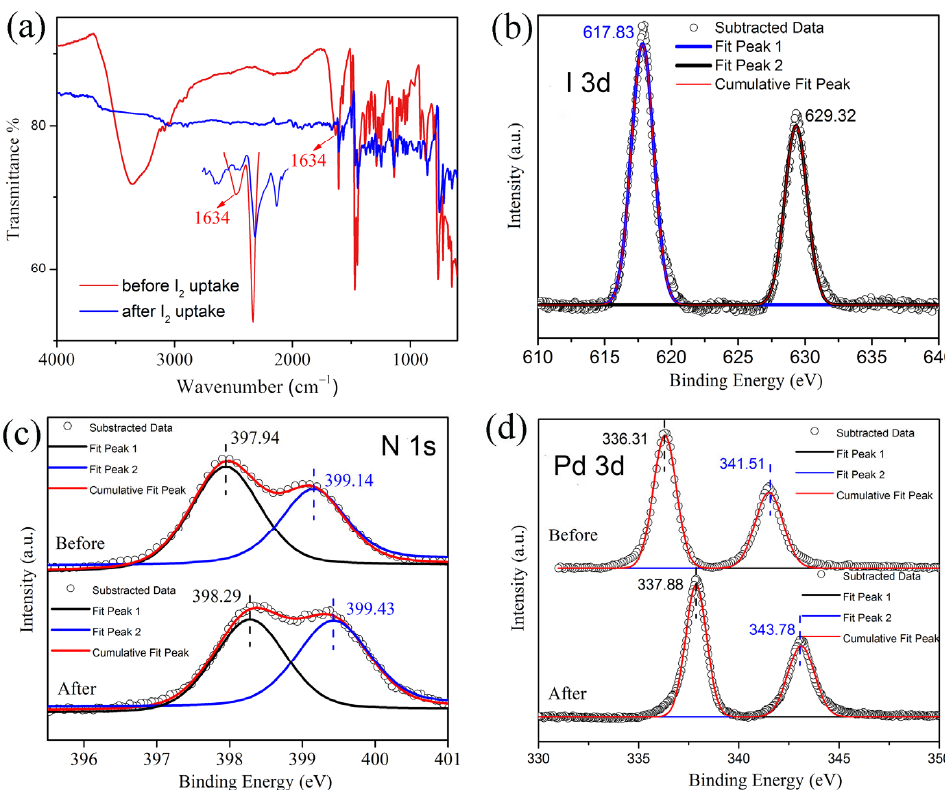
Figure 4 . ( a ) IR spectra of compound 1 before and after I 2 uptake (inset: enlarged spectra showing the significant decrease of band at ∼ 1640 cm − 1 ). ( b ) XPS of I 3d for I 2 @ 1 . ( c ) XPS of N 1s for compound 1 before and after dissolved I 2 uptake. ( d ) XPS of Pd 3d for compound 1 before and after dissolved I 2 uptake.